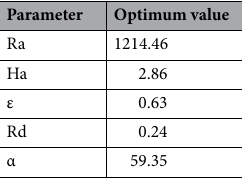
Table 4. Result of the optimization strategy by